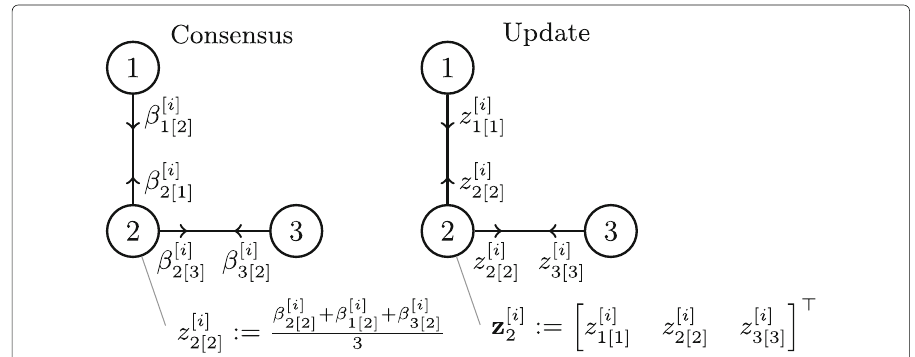
Fig. 2 The left part of the figure shows the communication done in the consensus step and how a consensus variable is calculated for the voltage of bus 2. On the right side, the exchange of the previously calculated consensus variables is